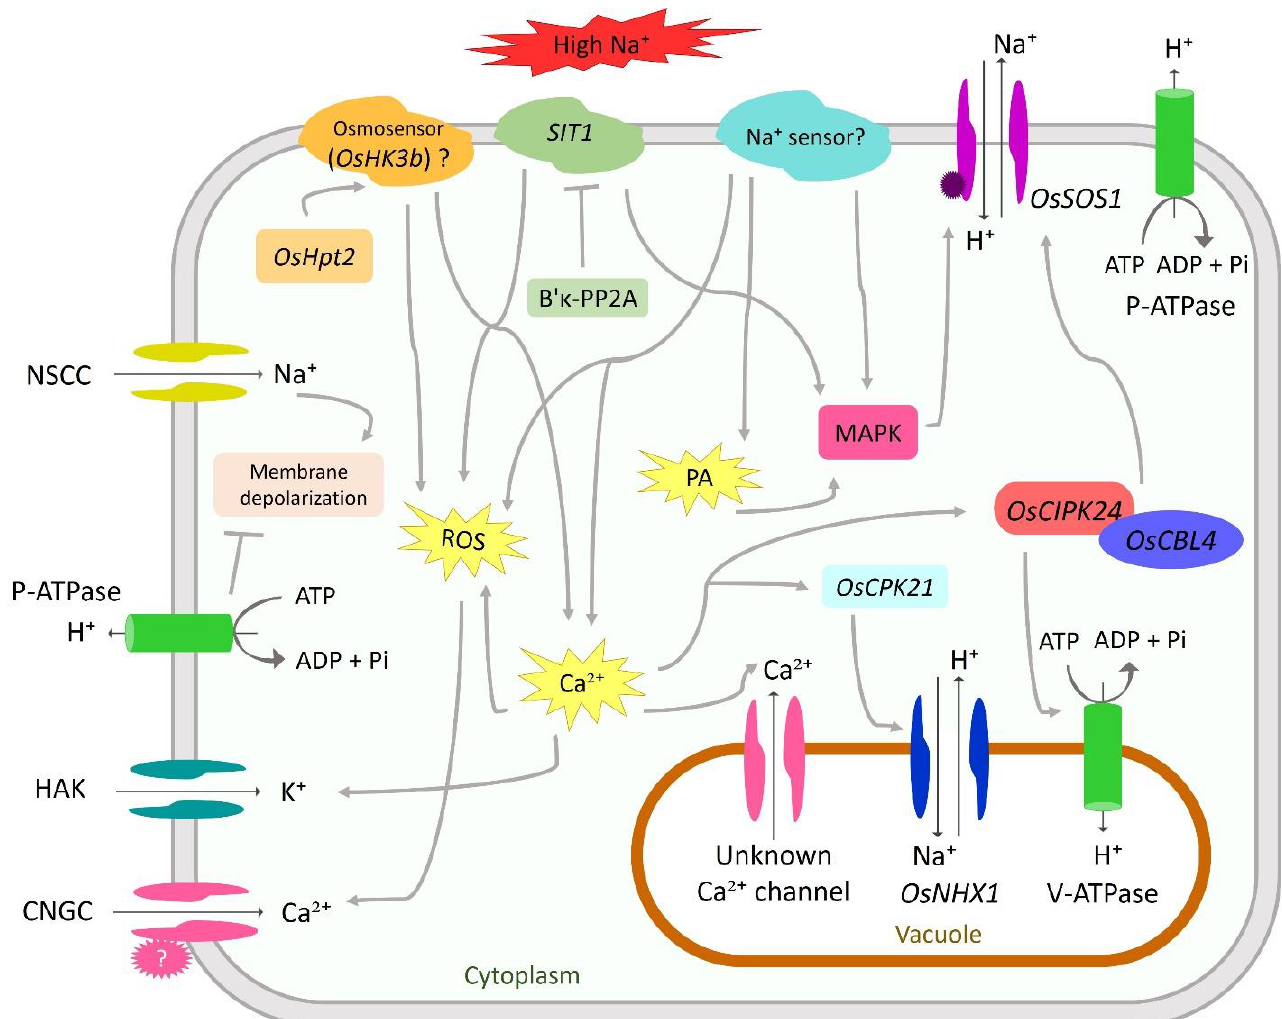
Figure 1. Salt sensing and signaling involved in rice responses to salt stress. Under high salinity, salt-induced osmotic stress begins, which is sensed by putative osmosensor OsHK3b , activated by OsHpt2 . SIT1 also acts as a sensor via elevated kinase activity and induces reactive oxygen species (ROS) production and mitogen-activated protein kinase (MAPK) signaling. The activity of SIT1 is deactivated by the B’ κ -PP2A subunit. Later, ionic stress occurs and is sensed by an unknown Na + sensor. The Na + enters the mature epidermal cell through nonselective cation channel (NSCC), causing membrane depolarization, and is polarized by P-type ATPases. Excess salt triggers a spike in the concentration of cytosolic secondary messengers, including Ca 2+ , reactive oxygen species (ROS), and phosphatidic acid (PA). ROS triggers Ca 2+ influx through the cyclic nucleotide-gated ion channel (CNGC), activated by an unknown molecule. Ca 2+ not only decreases K + efflux but also induces further ROS accumulation; thus, a positive feedback loop exists between Ca 2+ and ROS. The cytosolic Ca 2+ also induces vacuolar Ca 2+ release and activates Ca 2+ -binding proteins, such as OsCIPK24-OsCBL4 complex. This complex, together with MAPK, activated by phosphatidic acid, upregulates the OsSOS1 to remove cytosolic Na + . The vacuolar OsNHX1 gene is activated by OsCPK21 , whereas the V-type ATPase is activated by OsCIPK24 , establishing a proton gradient and driving the activity of OsNHX1 .